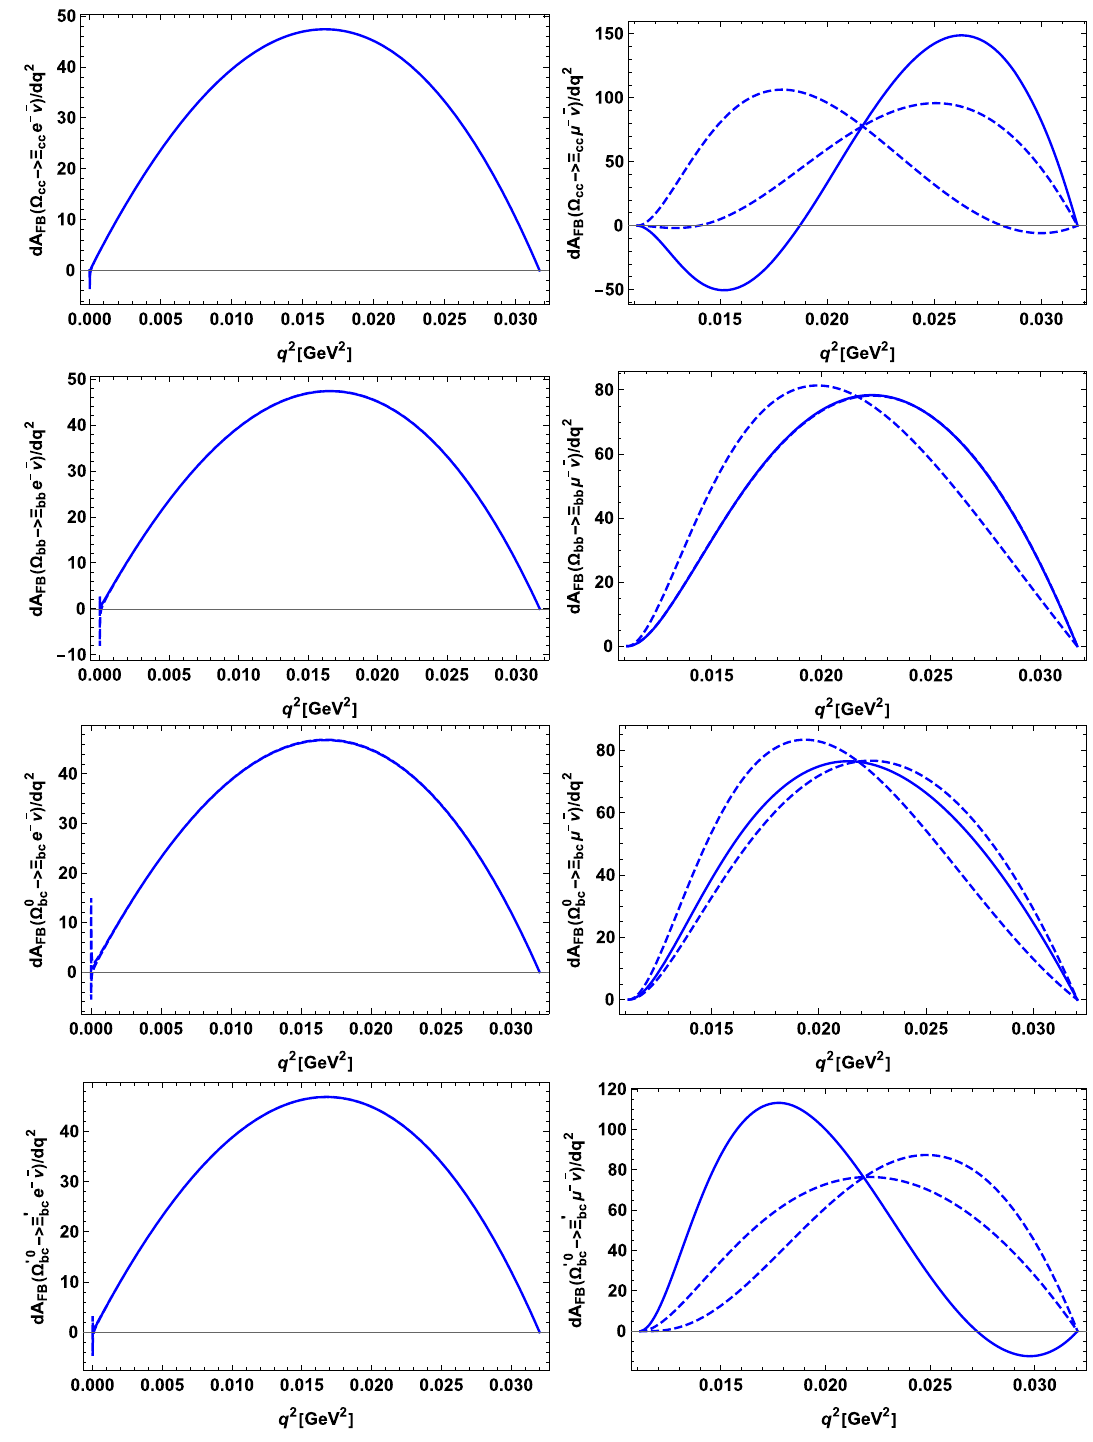
Fig. 7 The dA FB / dq 2 of spin-1/2 to spin-1/2 doubly heavy baryon decay processes. dA FB / dq 2 is depend on F ( q 2